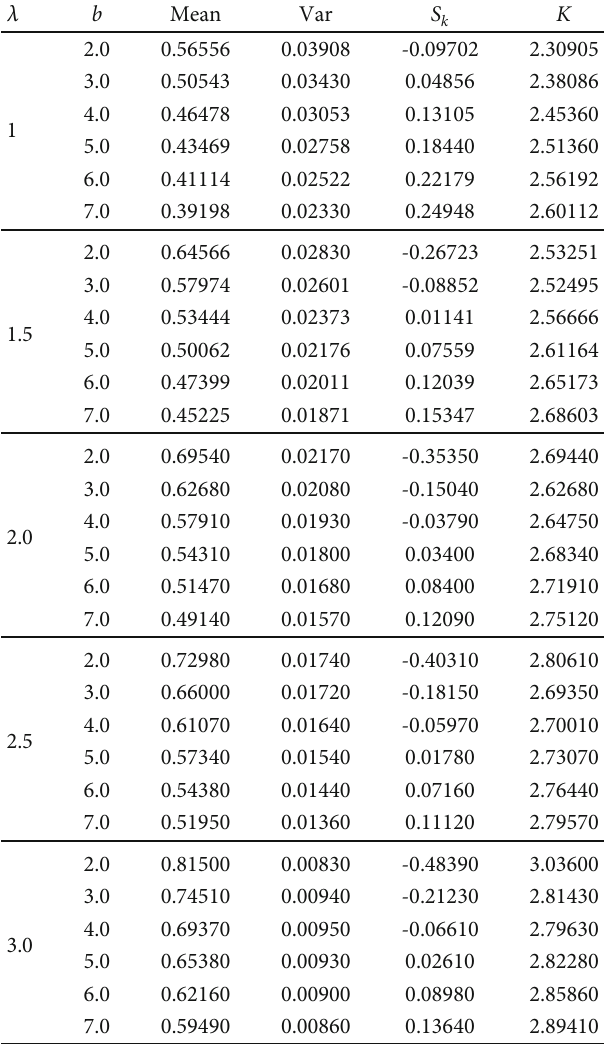
), and kurtosis ( K ) values